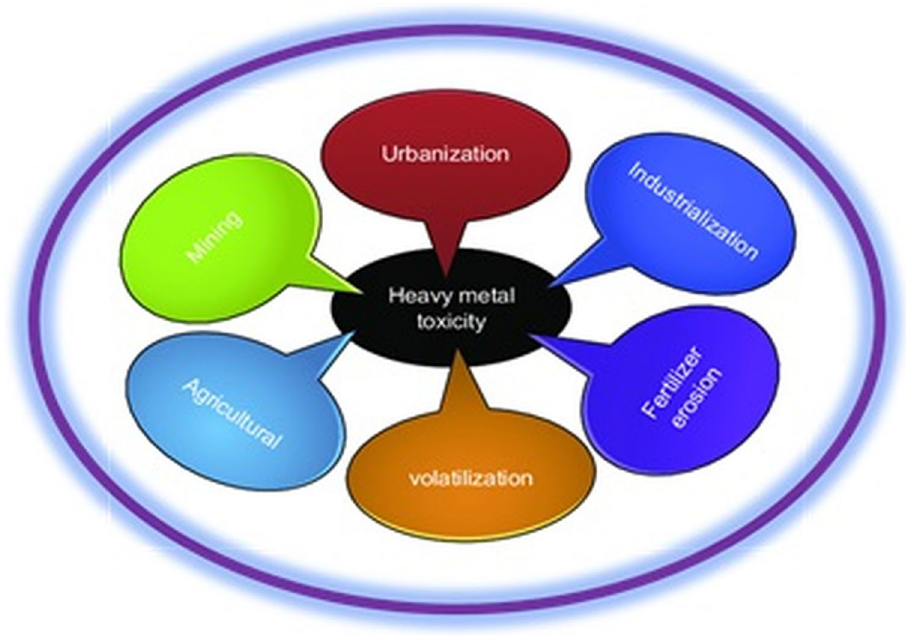
Fig. 5 Different causes of heavy metal toxicity in the environ-